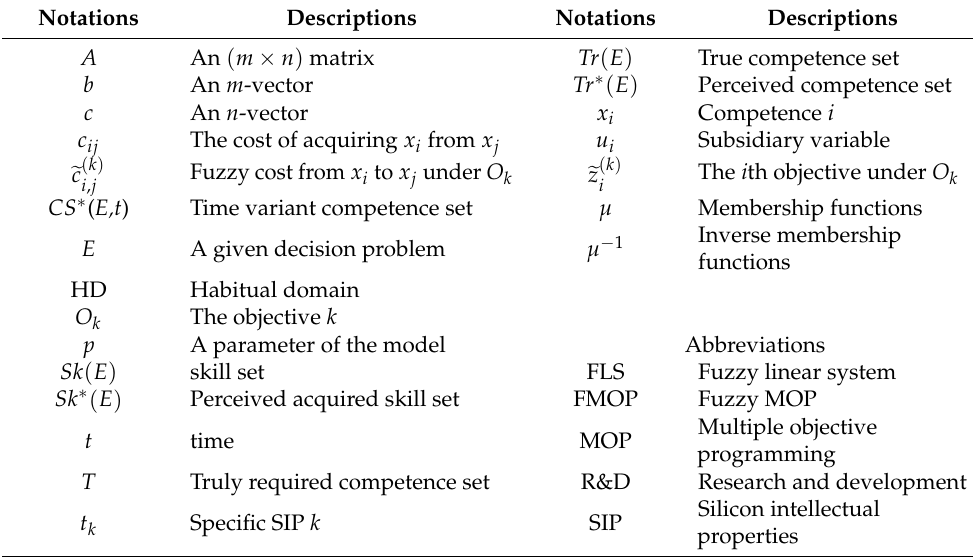
Table 1. Notations and